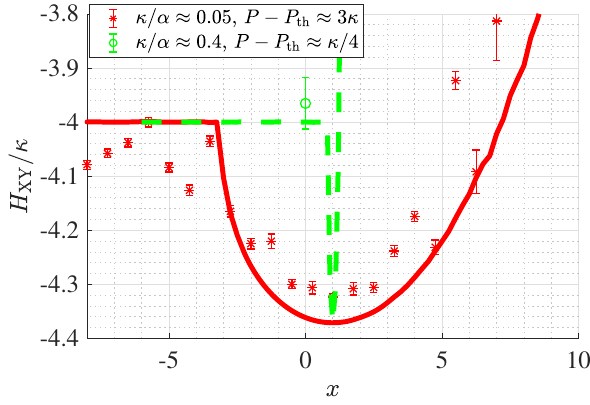
Figure4: CalculatedXYmodelenergyestimationfromlasernetwork fixed point phase versus x – comparison of measurement (markers) to theory (solid and dashed lines). Error bars are estimated as 67% con fi dence intervals.